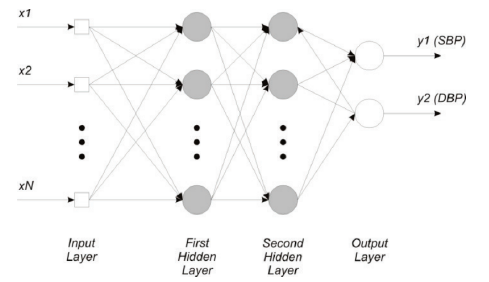
Figure 21. Sketch of a network used for blood pressure estimation. The figure shows the mapping from N features to SBP and DBP, using two hidden layers. Reprinted with permission from [6]. © 2013,